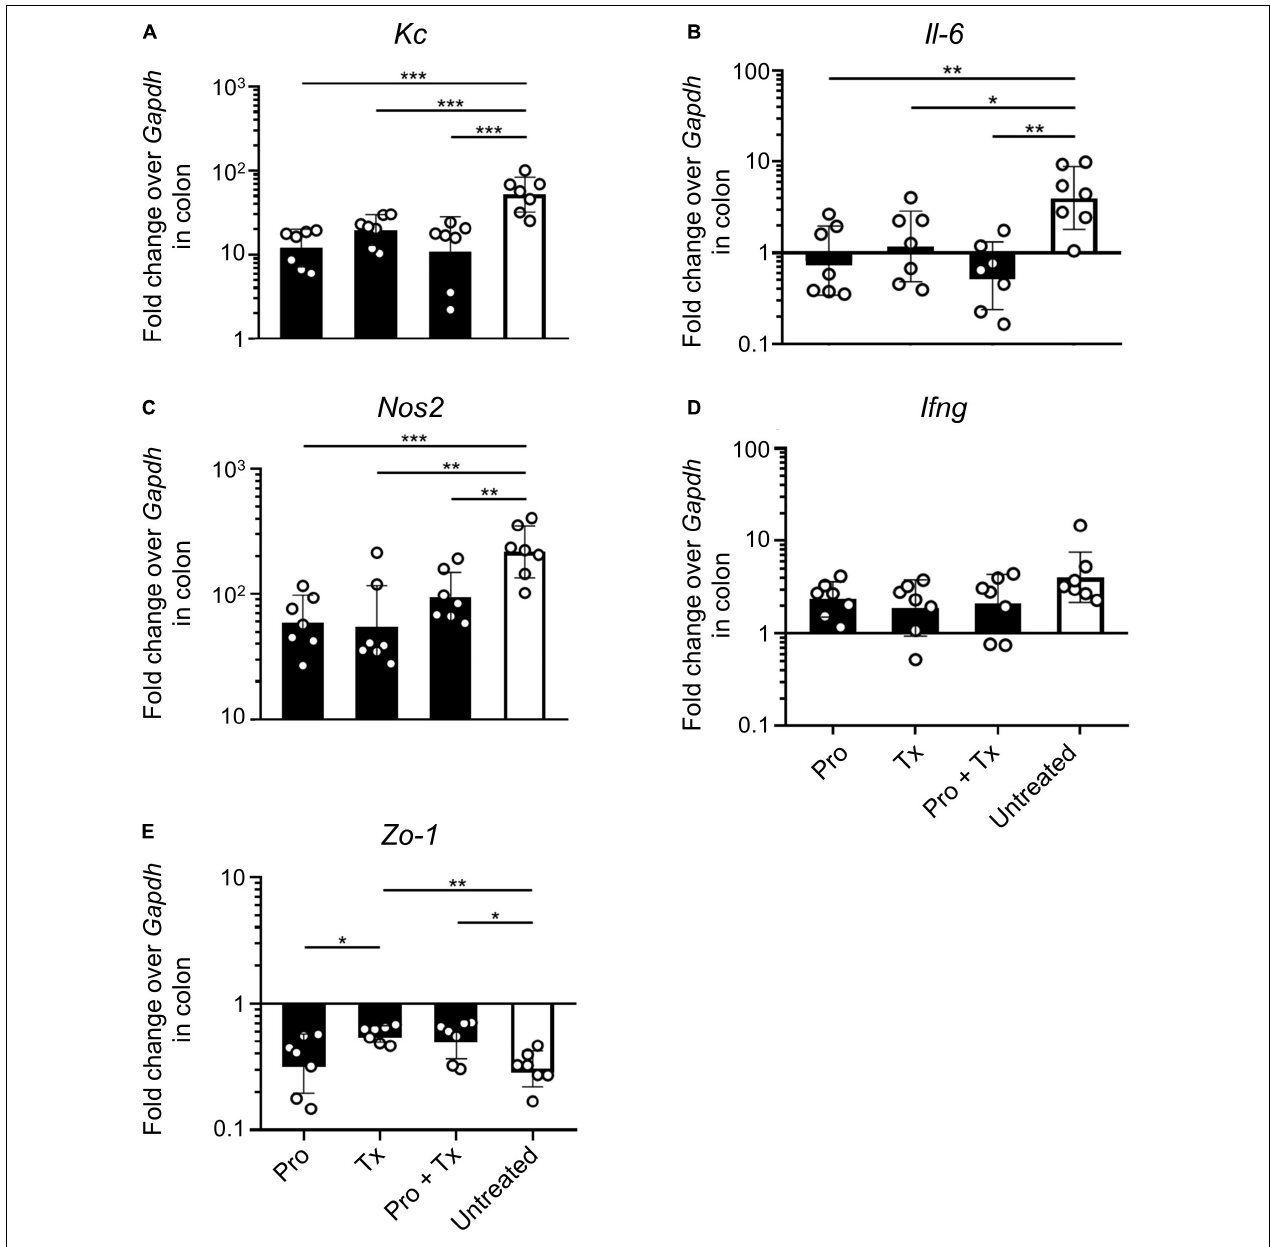
FIGURE 4 | Anti-inflammatory effect of L. reuteri KUB-AC5 on the STM-infected mouse colon. At day 4 post infection, mouse colons were collected and quantified for the fold change in mRNA expression of pro-inflammatory cytokines ( Kc , Il-6 , and Ifng ), iNOS ( Nos2 ), and tight junction protein ( Zo-1 ) by qPCR. All genes were analyzed with the comparative Ct method over the housekeeping gene Gapdh . Bars represent geometric means ± SD. * P < 0.05, ** P < 0.01, and *** P < 0.001 compared to all other